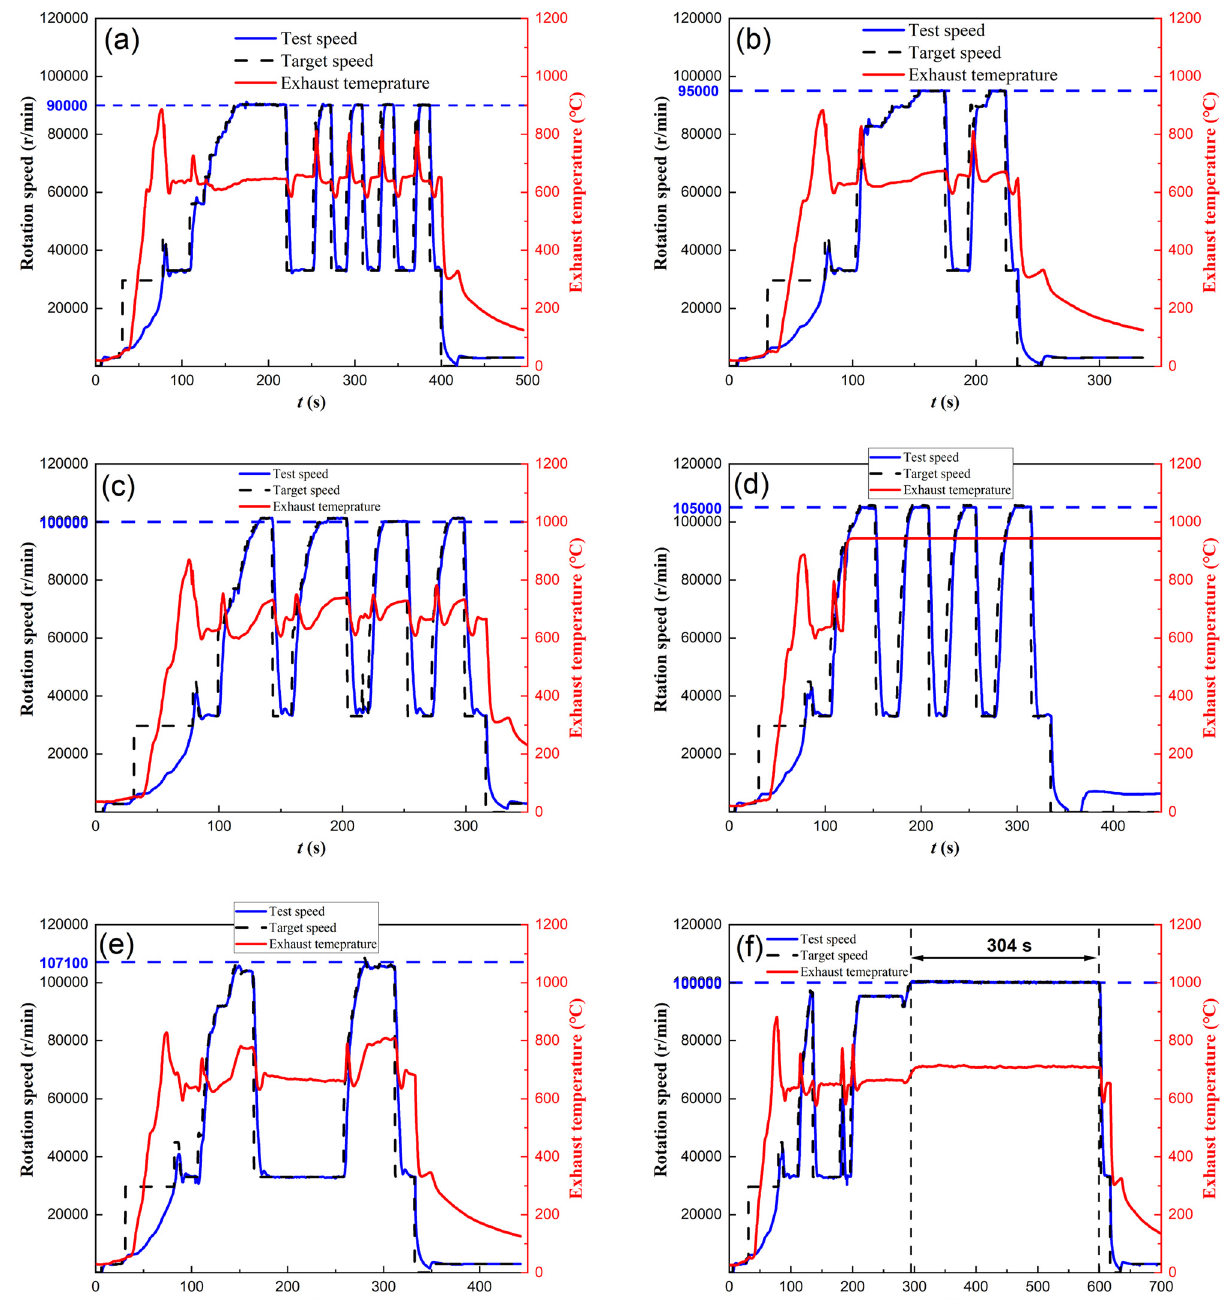
Figure 9: Test and target speeds and the exhaust temperature during the second testing. ( a ) n max = 90,000 rpm; ( b ) n max = 95,000 rpm; ( c ) n max = 100,000 rpm; ( d ) n max = 105,000 rpm; ( e ) n max = 107,100 rpm; and ( f ) n max = 100,000 rpm for 5